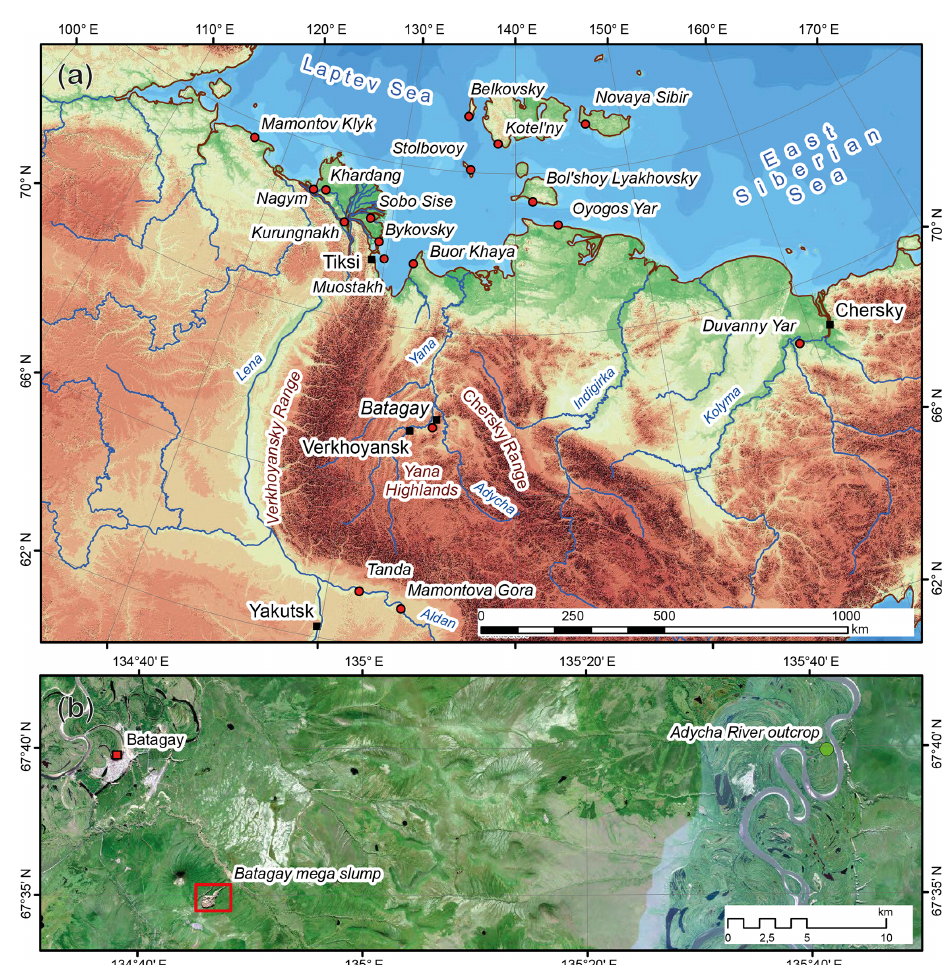
Figure 1. (a) Location map of study region in northeast Siberia showing all ice-wedge study sites mentioned. (b) Study sites in the Yana Highlands (background image: Sentinel-2 mosaic; 7 and 21 August